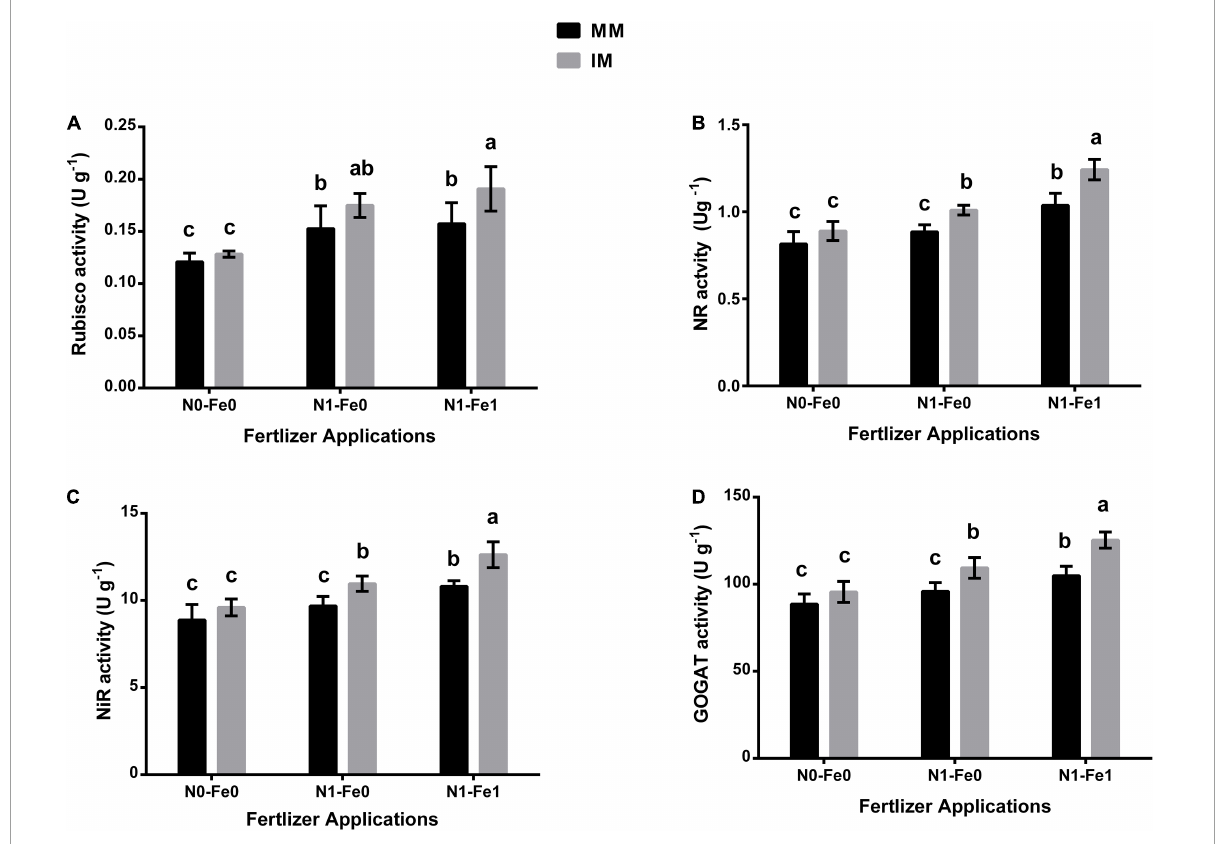
FIGURE4 Enzymatic activities such as Rubisco activity (A) , NR activity (B) , NiR activity (C) , and GOGAT activity (D) of maize leaf as influenced by different fertilizer and planting patterns. The column graphs with SD bars having dissimilar lower case letters are significantly different from each other at the LSD test ( p < 0.05). MM, maize mono-cropping; IM, maize intercropping; NR, nitrate reductase; NiR, nitrite reductase; GOGAT, glutamate synthase; N0-Fe0, no nitrogen and iron fertilization; N1-Fe0, nitrogen fertilization without iron foliation; N1-Fe1, nitrogen fertilization with iron